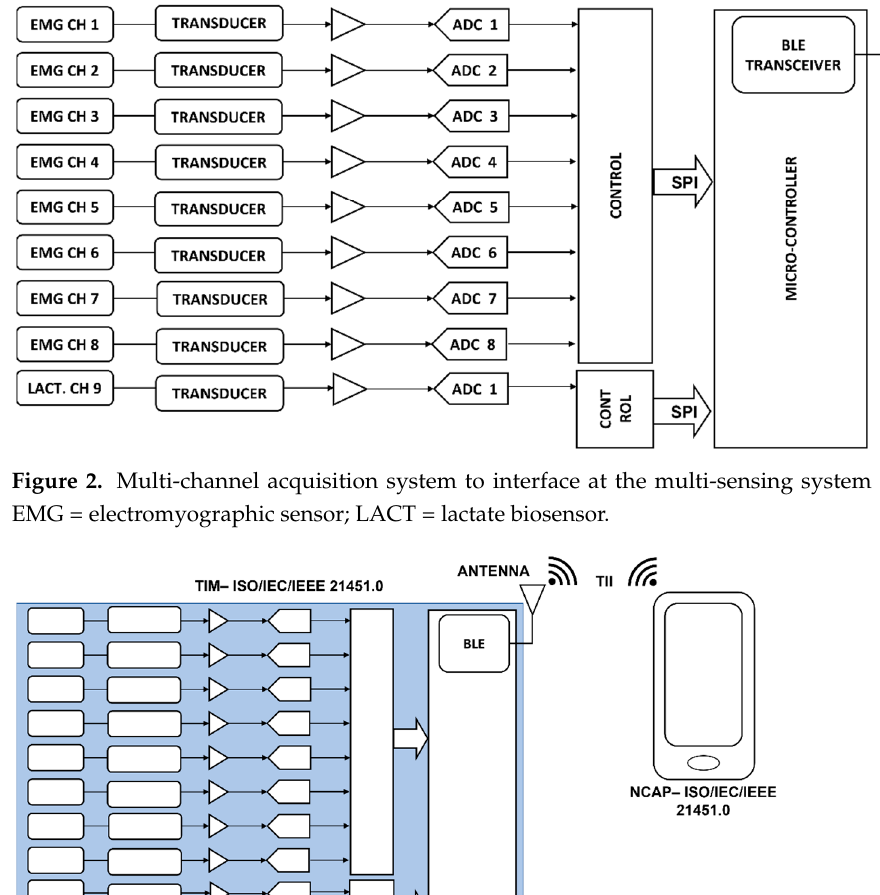
Figure 2. Multi-channel acquisition system to interface at the multi-sensing system in Figure 1. EMG = electromyographic sensor; LACT = lactate biosensor.